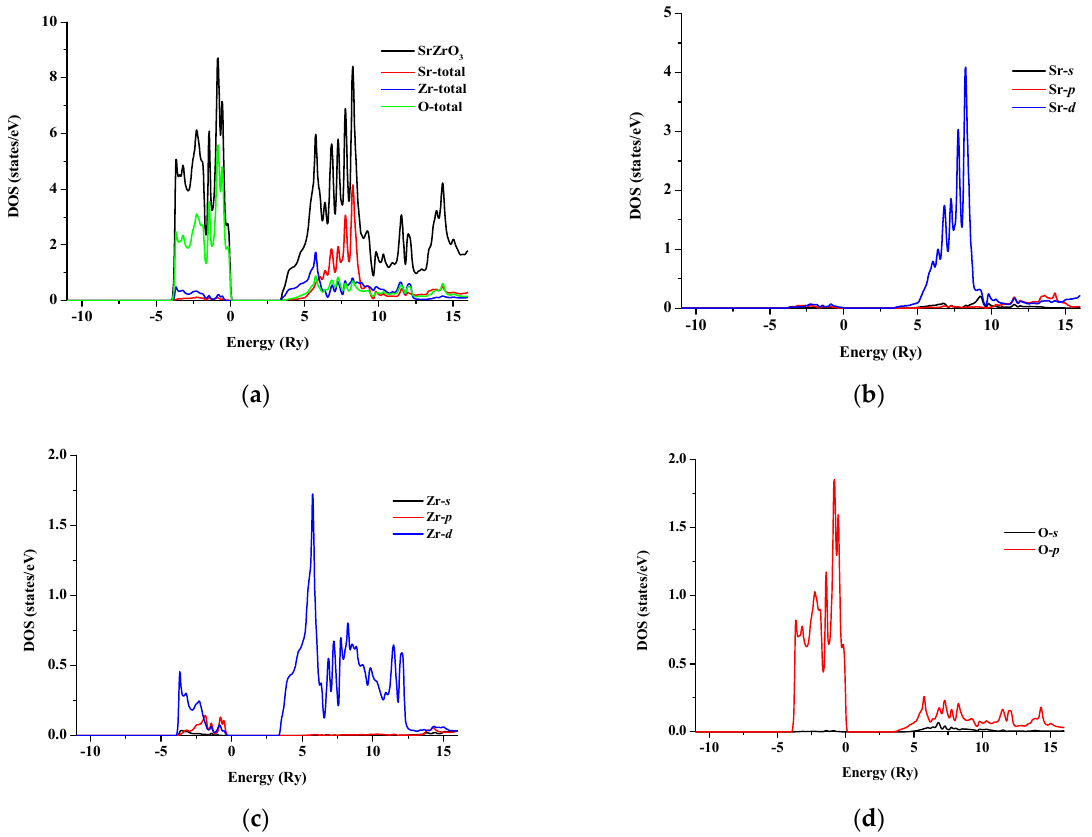
Figure 6. ( a ) Total density of states of SrZrO 3 ; Partial density of state for ( b ) Sr atom, ( c ) Zr atom and ( d ) O atom in SrZrO 3 compound.